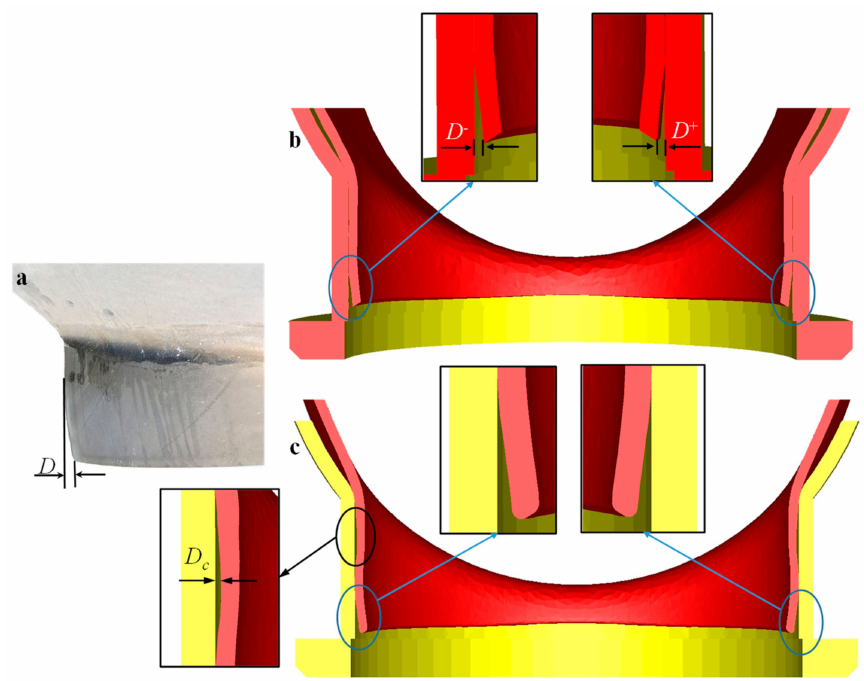
Figure 11. Shrinking on the end of branch pipe: ( a ) experiment; ( b ) finite element method (FEM) result by the modeling method in this study; ( c ) FEM result by the modeling method in the study [25]. Generally, the maximum of shrinking on the end of the branch pipe appeared near the z axis.